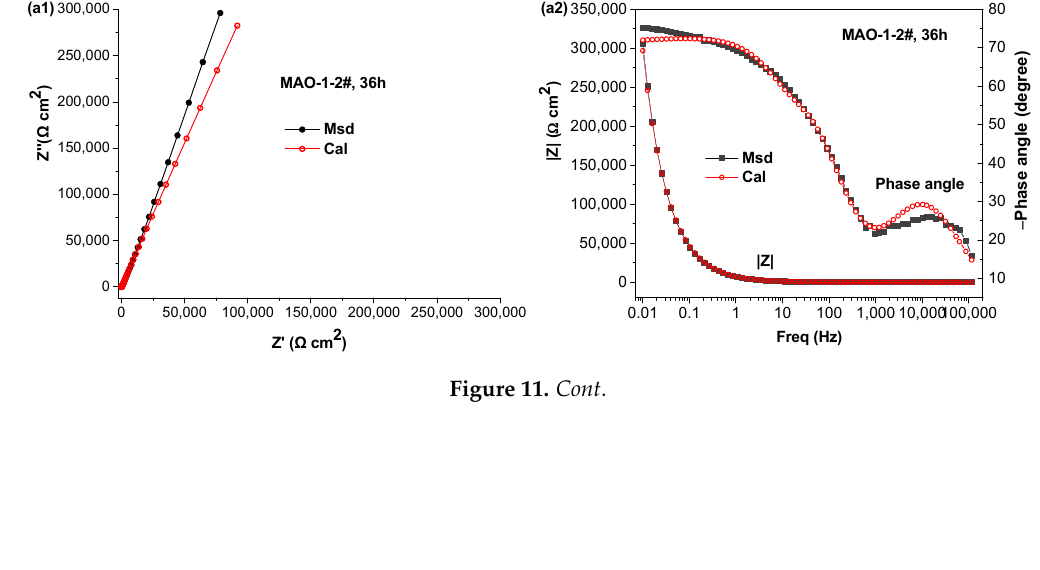
Figure 11. Fitting Nyquist and Bode graph of EIS spectra of ( a1 , a2 ) MAO-1-2# and ( b1 , b2 ) untreated TA2 after 36 h im- mersion in 3.5%NaCl solution. Equivalent circuit model R s ( Q p ( R p ( Q b ( R b Q d )))) and R s ( Q b ( Q d R b ) were used to fit the spectrum of MAO-1-2# and bare TA2 specimens, respectively. The fitting parameters of EIS data are shown in Table 1. Figure 9 and Table 1 show that the EIS of parallel MAO-1 samples have a good reproducibility, but there are differ- ences of the EIS spectra for the parallel MAO-2 samples. The resistance value ( R b + R p ) of MAO-2-3# is significantly greater than that of MAO-2-1# and MAO-2-2#, but significantly less than that of MAO-1 samples. Table 1. The Fitting resistance values of EIS data of MAO specimens measured after 12 and 36 h immersion in 3.5% NaCl solution, respectively. Sample 479.9 Compared with the previous OCP results of MAO, it can be seen that the results of resistances well correspond with OCP. The OCP values of MAO-2 specimen are lower than those of MAO-1 specimen, and the resistance values ( R b + R p ) of MAO-2 coatings are also lower than MAO-1 specimen. The OCP of MAO-2-1# and MAO-2-2# specimens are